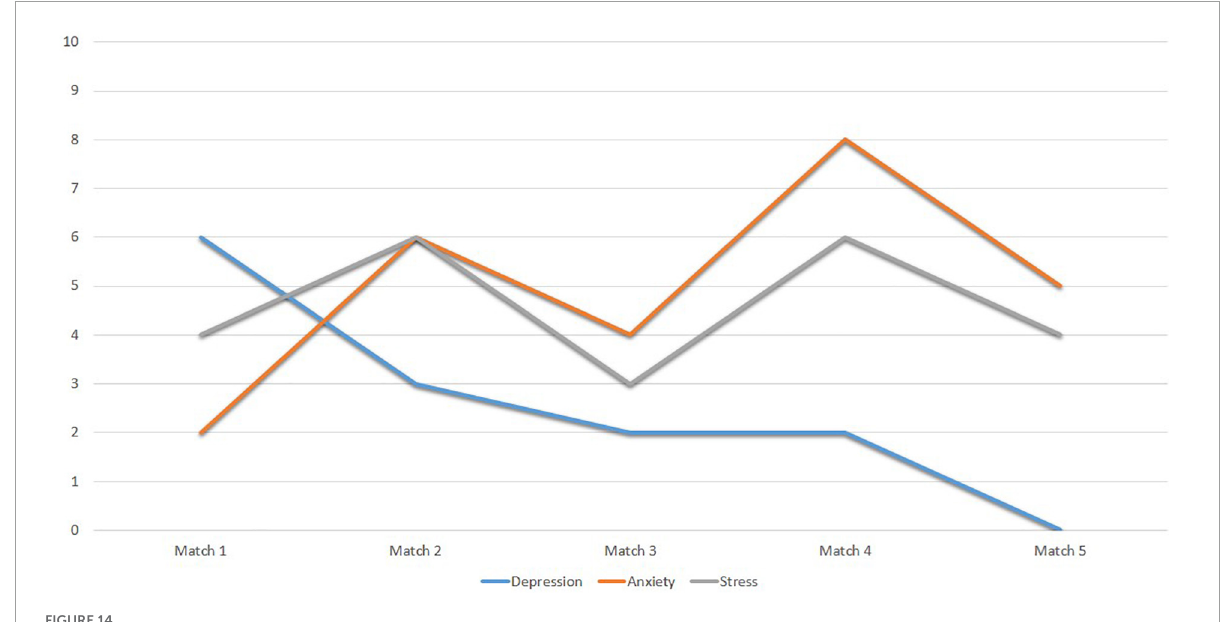
FIGURE14 Scores of subject 4 to the subscales of the